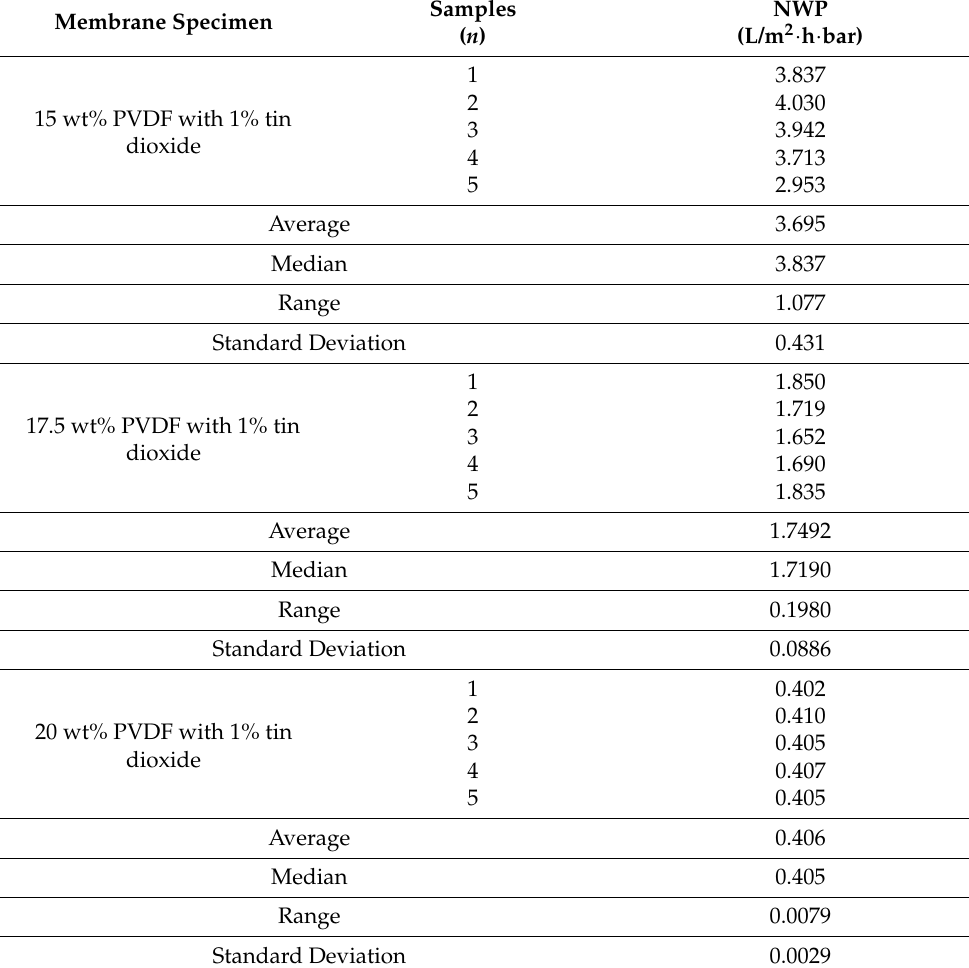
Table 2. Membrane permeability performance of the PVDF and tin dioxide